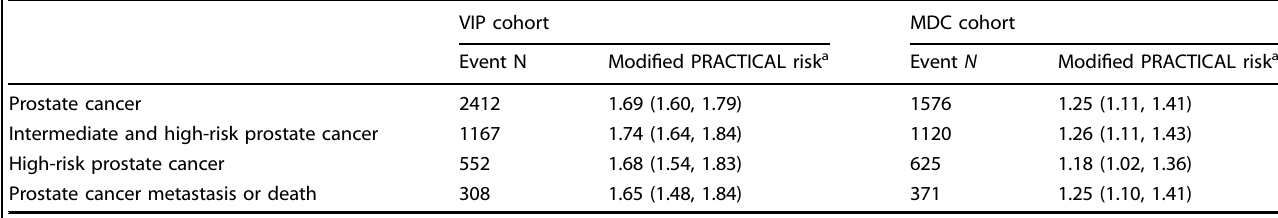
Table 5. Association between polygenic risk scores and four nested outcomes in the VIP and MDC cohorts